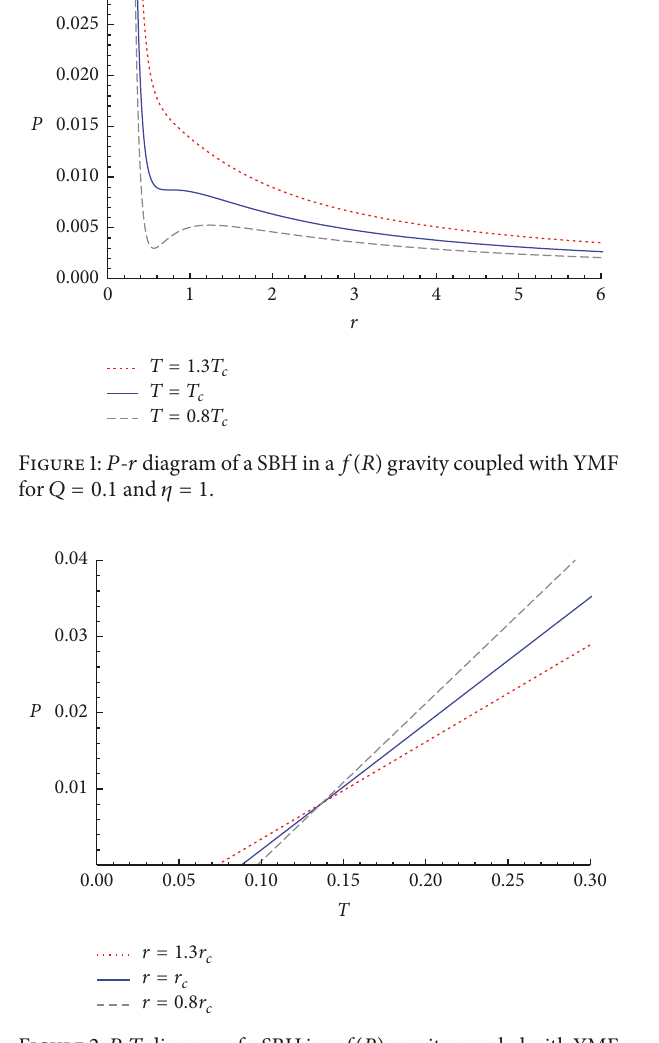
Figure2: 𝑃 - 𝑇 diagramofaSBHina 𝑓(𝑅) gravity coupled withYMF for 𝑄 = 0.1 and 𝜂 = 1 .